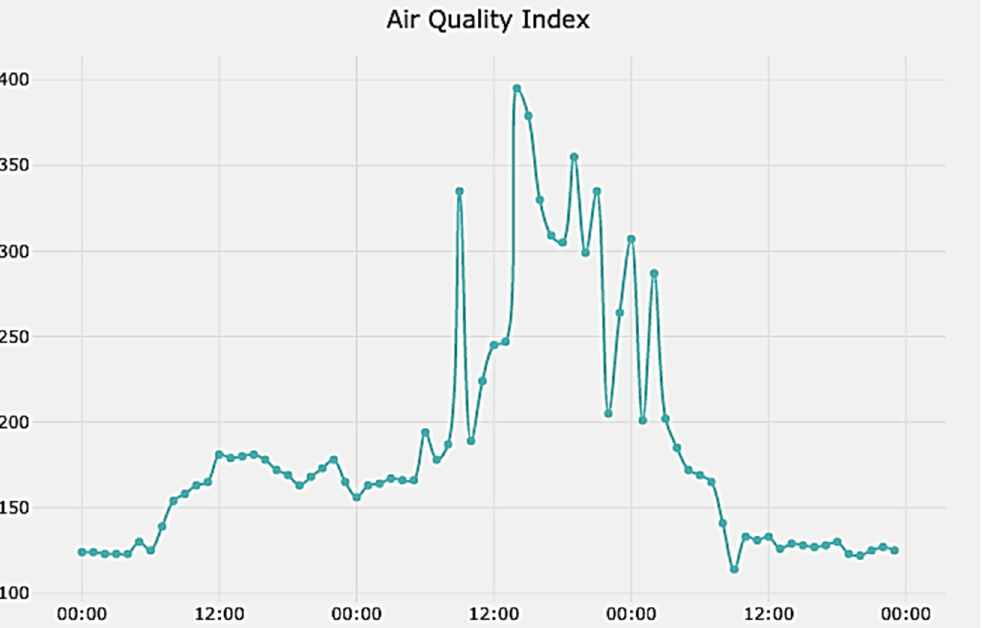
changes caused by this event were registered. In future events, a comparison of magni- Figure 7. Hourly aggregated air quality index time series between 22 and 24 June 2020. After the event, the platform was used to create awareness of the danger of the par-